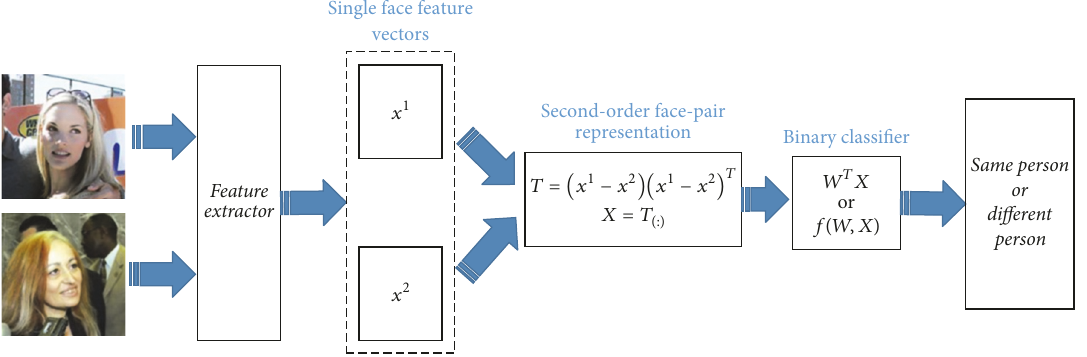
Figure 3: The overall framework of face verification based on the second-order face-pair representation.